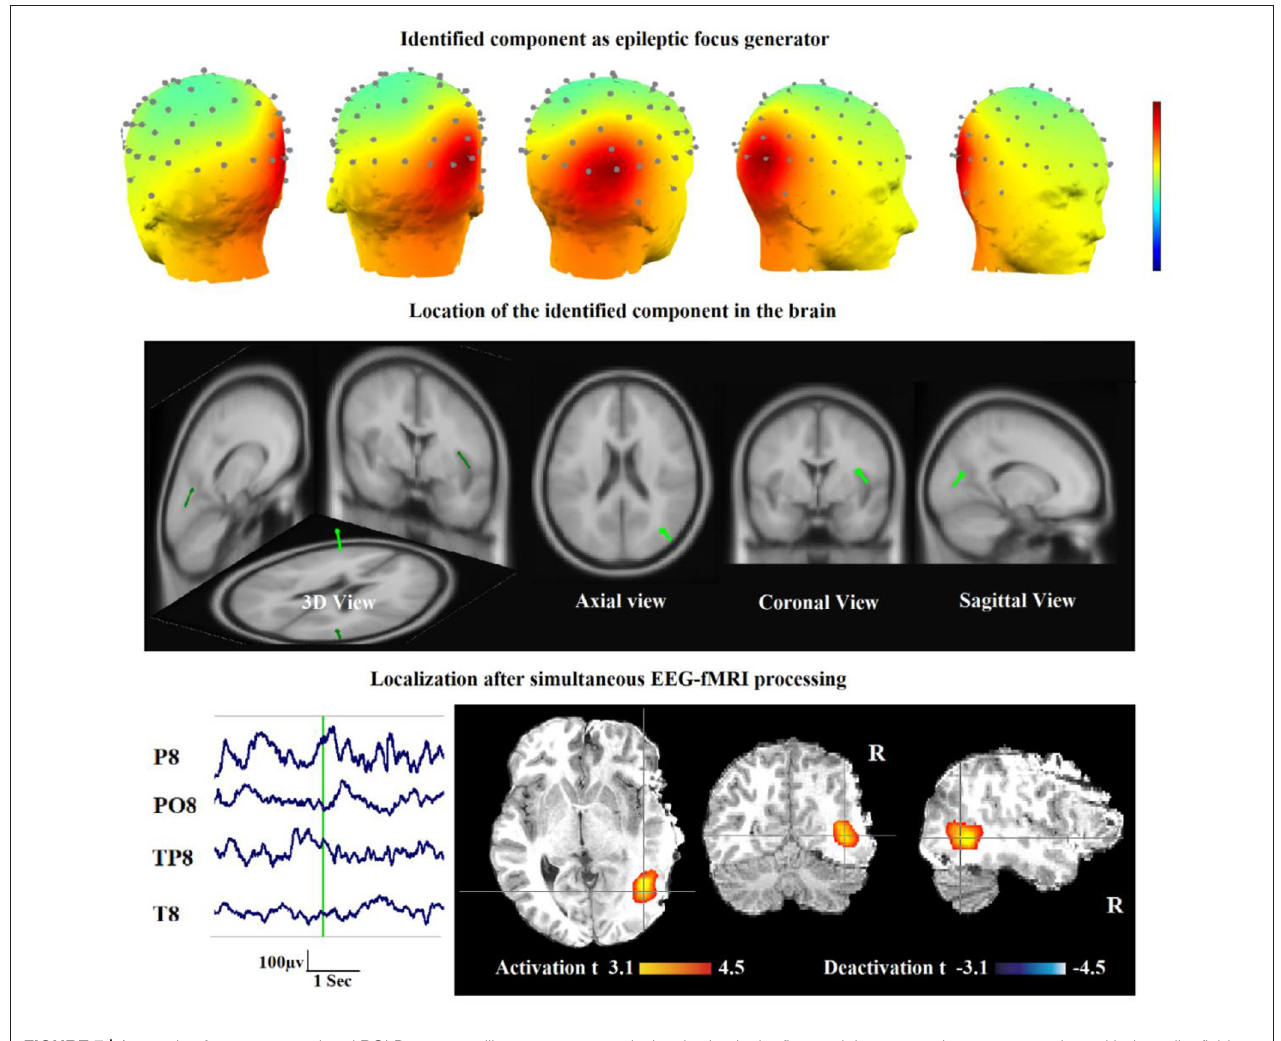
FIGURE 7 | A sample of component-related BOLD response illustrates a neocortical activation in the first occipito-temporal cortex concordant with the spike field. Also, the marked events are in P8, PO8, and TP8 with referential montage. Top: The identified epilepsy-related component located in the right occipito-temporal lobe. Middle: The result of dipole-based localization of the identified component. Bottom: The localization of the epileptic generator acquired from simultaneous EEG–fMRI analysis (